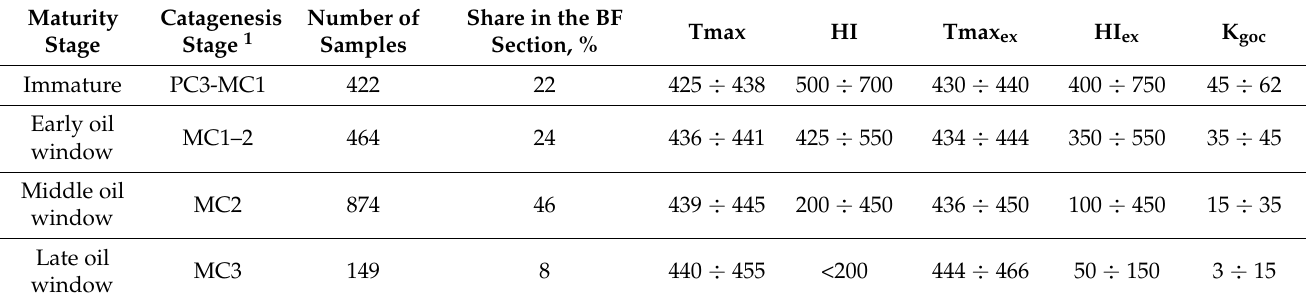
Table 1. Characteristic ranges of pyrolysis parameters for the Bazhenov Formation (BF) samples at different maturity stages.